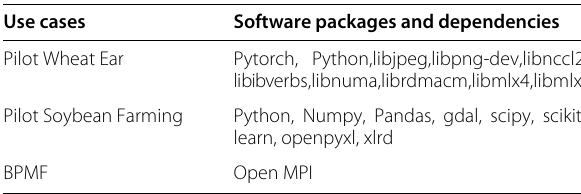
Table 2 The key software packages and their dependencies packed in Singularity images for each application